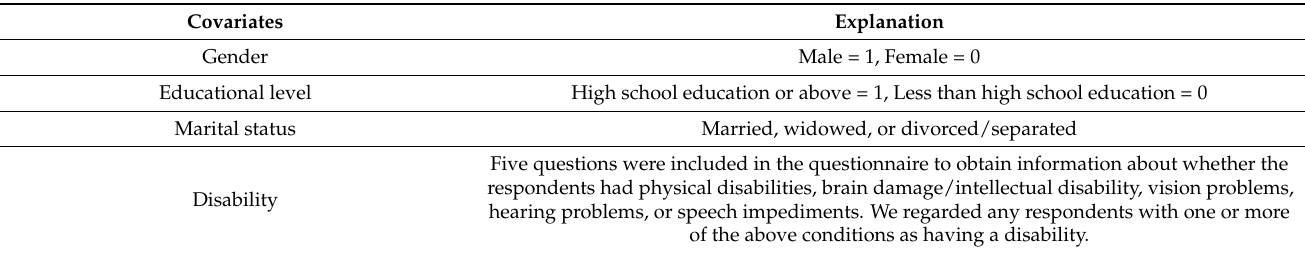
Table A1. Explanation of the Partial